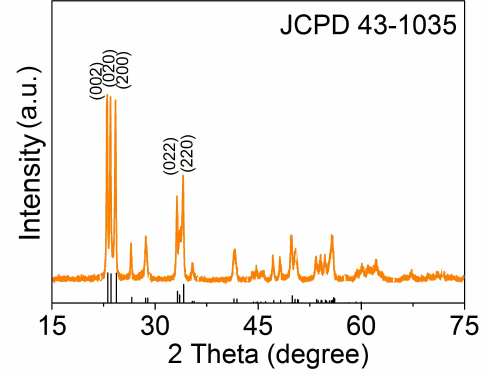
Figure 3. XRD pattern of the 3DIO WO 3 sample.